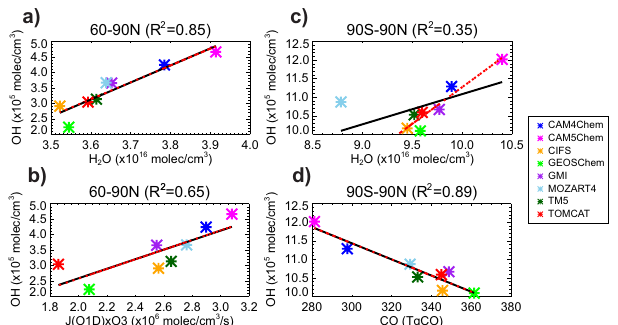
Figure 12. Annual mass-weighted tropospheric mean OH concen- tration (a) against annual mass-weighted mean water vapour in the Arctic, (b) against annual mass-weighted mean photolysis rates of J (O 1 D) multiplied by O 3 concentrations in the Arctic, (c) against annual mass-weighted mean water vapour concentrations for the whole troposphere, and (d) against the annual mean CO burden for the whole troposphere. The ordinary least squares (OLS) and the iteratively re-weighted least squares (IRLS) regression lines are shown in black and red, respectively. Correlations equal to or above 0.62 are significant at the 90% confidence level (CL) or above. The troposphere has been selected using the 150ppbv O 3 contour. See Table S1 for more